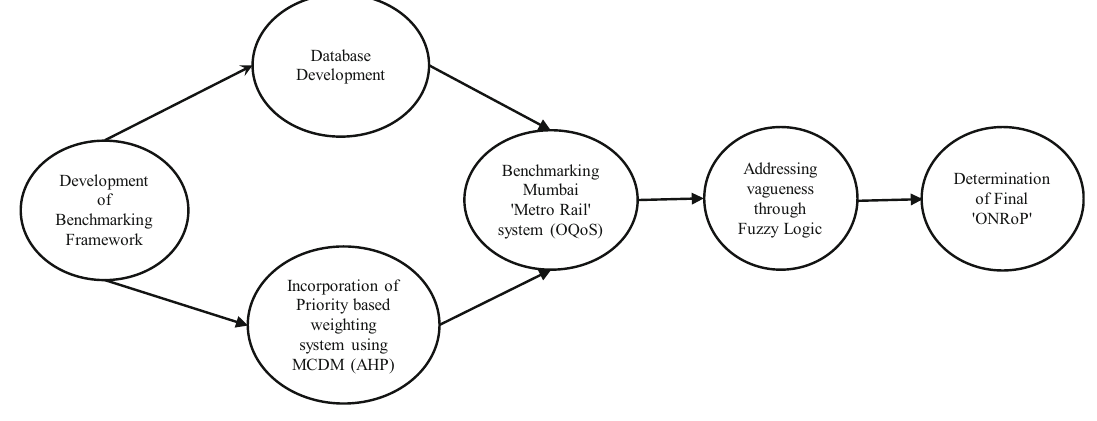
Fig. 2 Methodology for benchmarking of Metro Rail